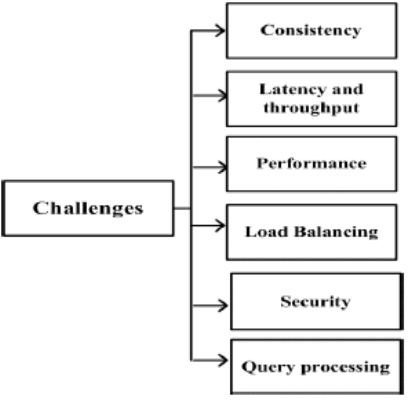
Figure 5. Classification of research on key-value store.